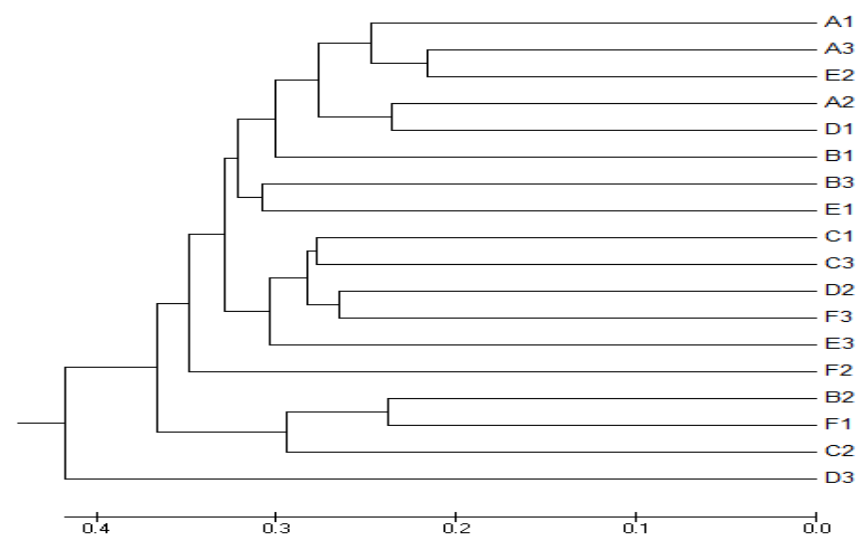
Figure 6. Dendrogram of Cinnamomum camphora leaf bacteria showing the structural similarity of 18 samples.